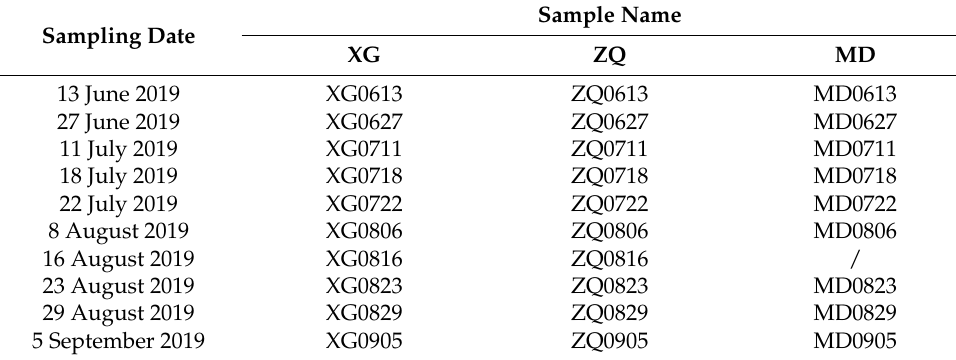
Figure 1. Locations of sampling stations in coastal Qingdao areas during the green tide. Table 1. Sampling information.